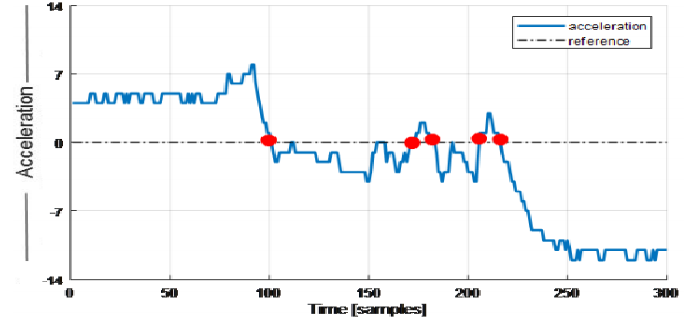
Figure 4. The instantaneous vector magnitude for the walking signal pattern.